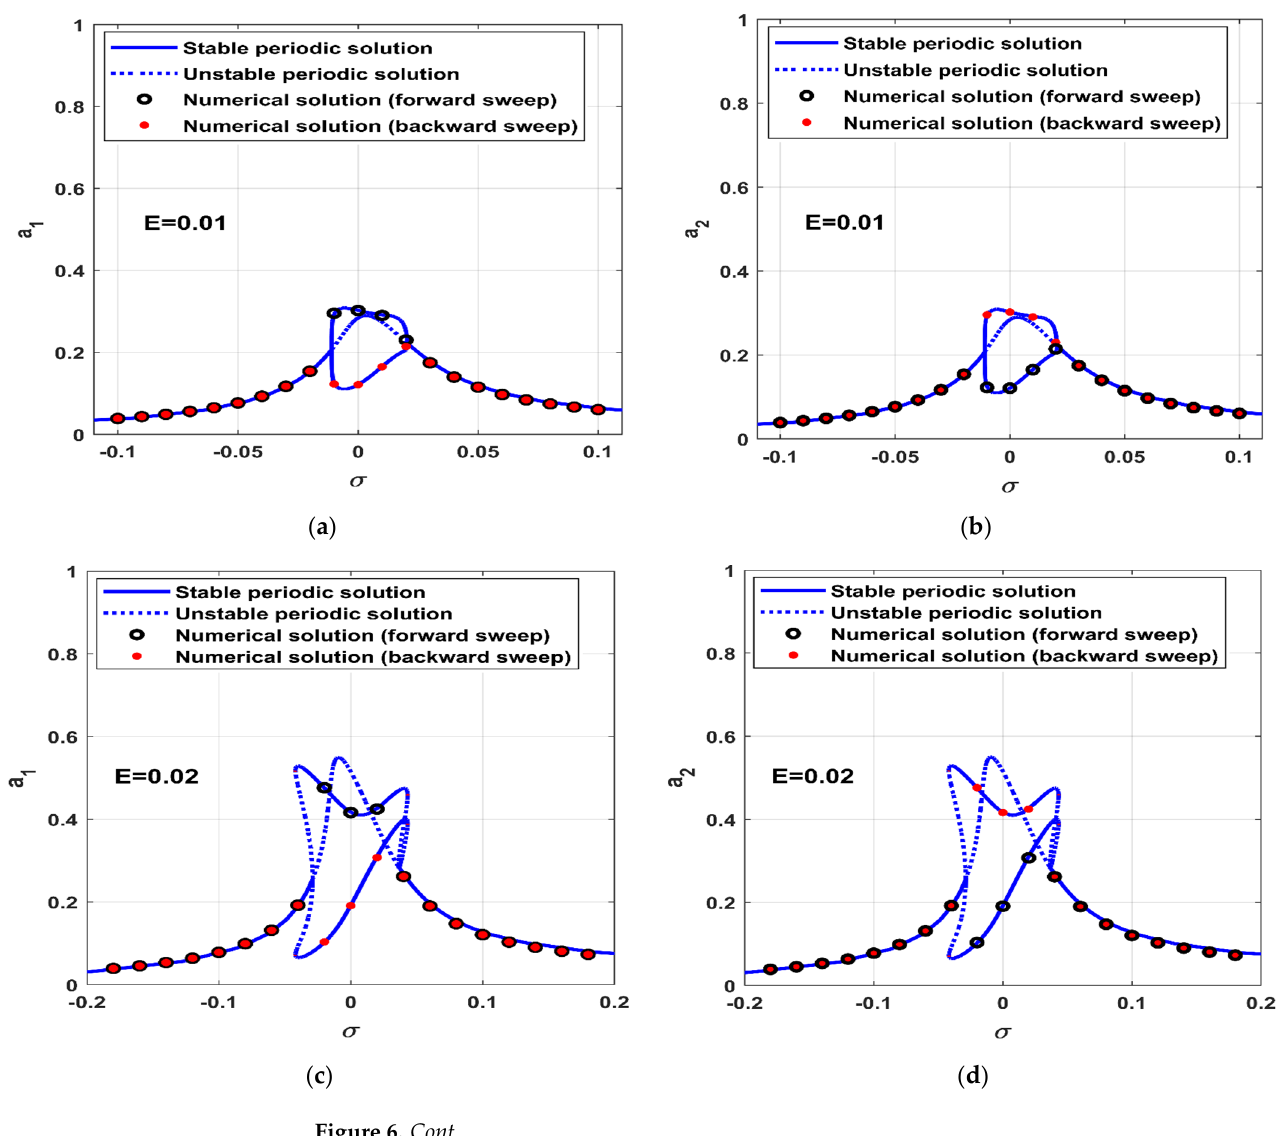
( f ) Figure 6. 𝜎 − response curve of the controlled Jeffcott rotor (i.e., 𝛿 (cid:2869) = 0.83 , and 𝛿 (cid:2870) = 0.002 ) at three different values of the shaft eccentricity 𝐸 : ( a , b ) oscillation amplitudes ( 𝑎 (cid:2869) and 𝑎 (cid:2870) ) versus 𝜎 when 𝐸 = 0.01 , ( c , d ) oscillation amplitudes ( 𝑎 (cid:2869) and 𝑎 (cid:2870) ) versus 𝜎 when 𝐸 = 0.02 , and ( e , f ) oscillation amplitudes ( 𝑎 (cid:2869) and 𝑎 (cid:2870) ) versus 𝜎 when 𝐸 = 0.03 .